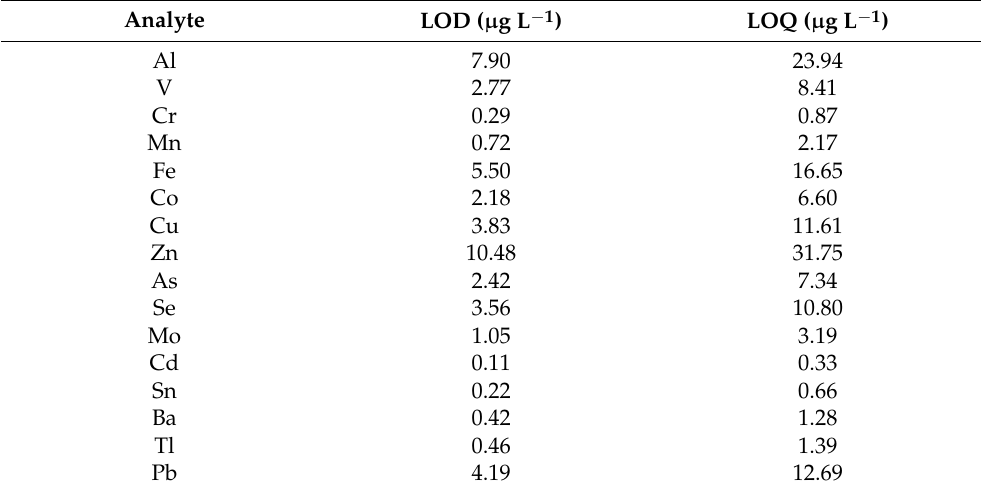
Table 6. Limit of detection (LOD) and limit of quantification (LOQ) of the method performed in this study.